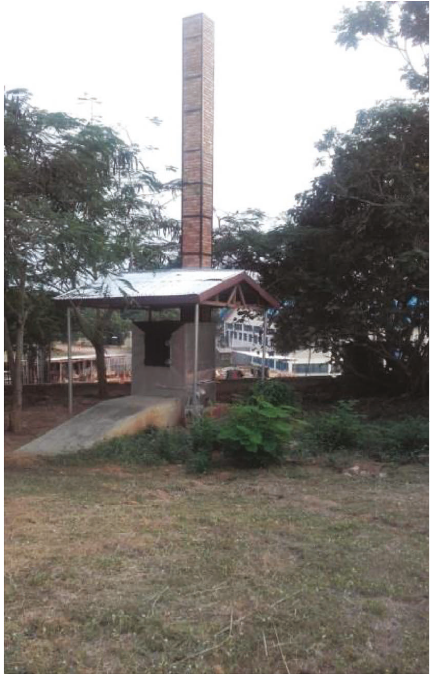
Figure 1: Locally-made hospital